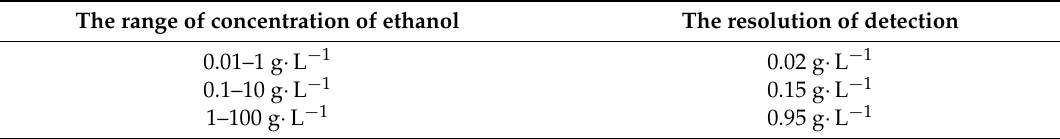
Figure 6. Dynamic range of the microfluidic assay. Inset shows dependence of absorbance on concentration of ethanol for concentrations of ethanol 1–10 g·L −1 . Table 1. The detection resolution of our method vs. the range of ethanol concentration.